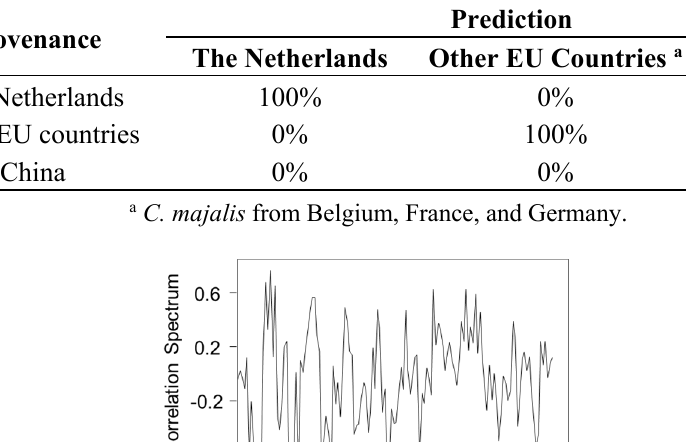
Table 2. PLS-DA (Partial Least Squares-Discriminant Analysis) leave-one-out cross validation results: classification of C. majalis from The Netherlands, other EU countries and China by their normalized and auto-scaled PTR-MS (proton transfer reaction mass spectrometry) spectral data. Provenance